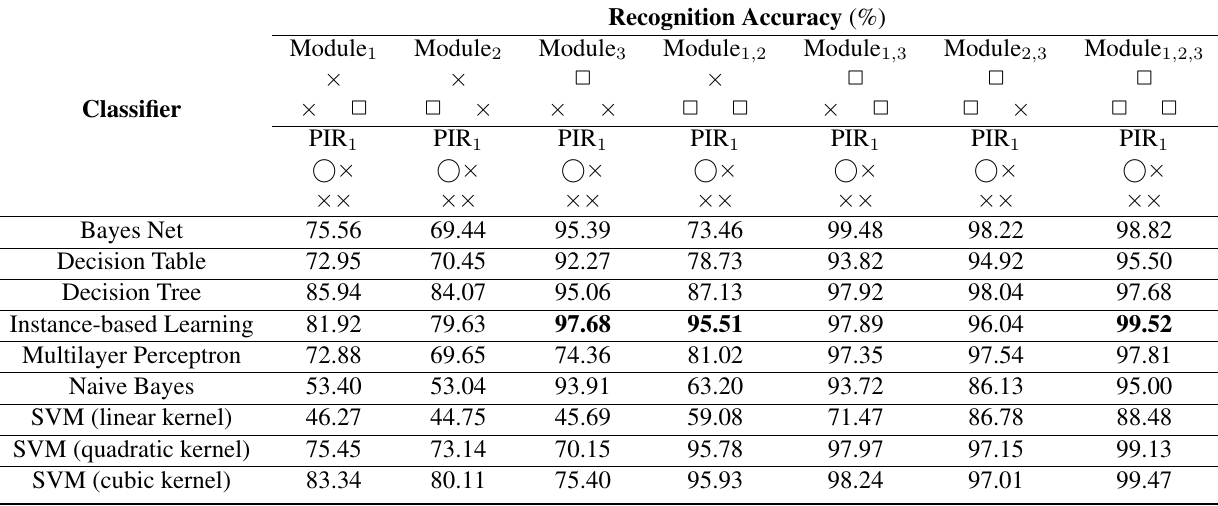
Table 4. Comparison of the recognition accuracy (%) of classifying the walking distance intervals based on the raw data set (PIR ) with respect to the number of 1